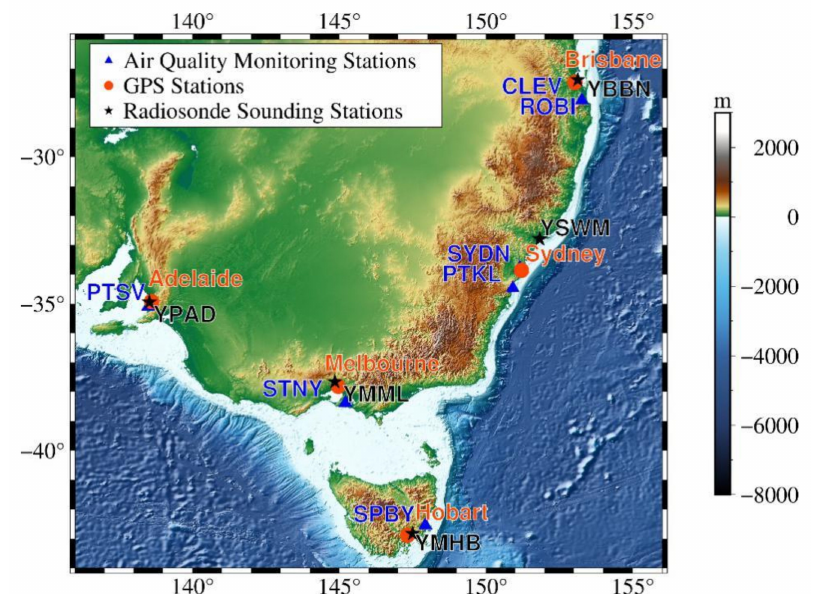
Figure 1. Geographical distribution of global navigation satellite system (GNSS) stations, radiosonde stations, and air quality monitoring